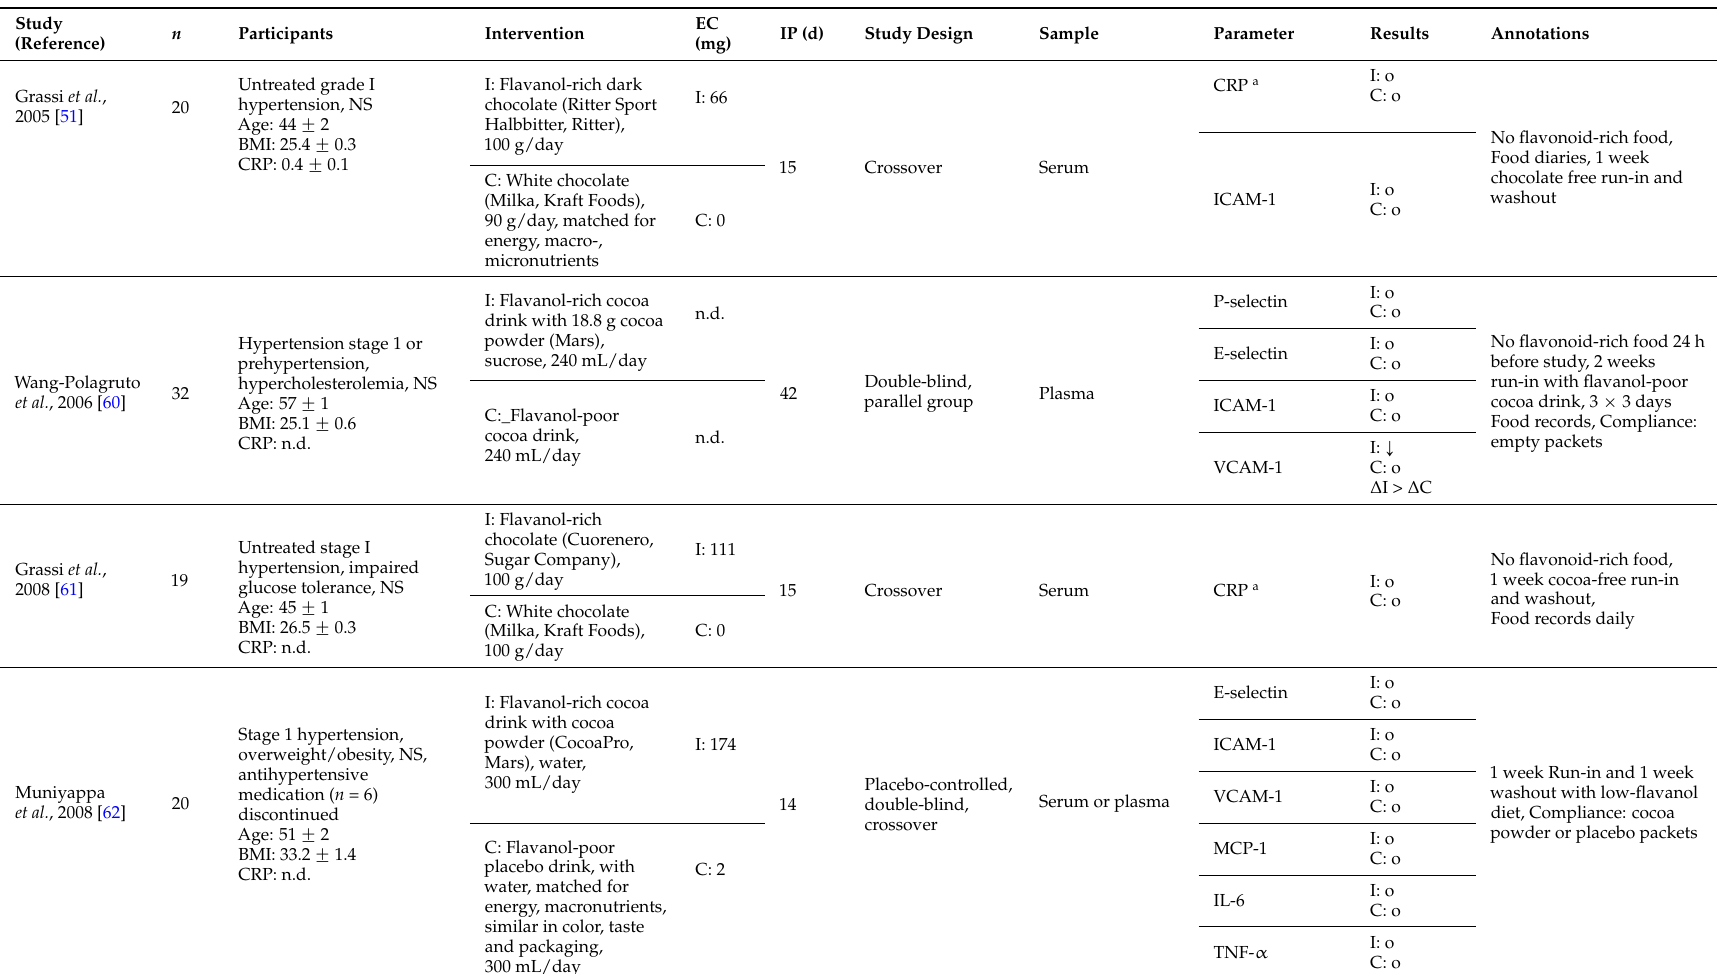
Table 3. Effect of regular cocoa consumption on inflammation in patients with pre-/hypertension—results from randomized, controlled trials. Study n Participants Intervention EC (Reference) (mg) IP (d) Study Design Sample Parameter Results